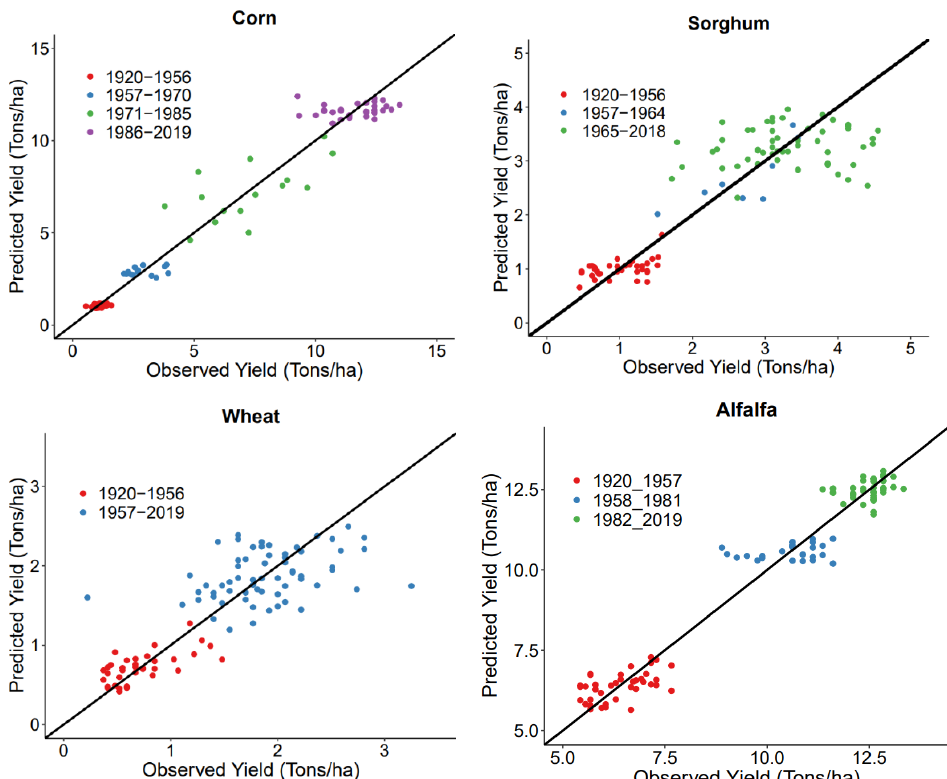
Figure 7. The scatter plot of observed and predicted corn, sorghum, wheat, and alfalfa yields resulting from the best models in segmented time scales.